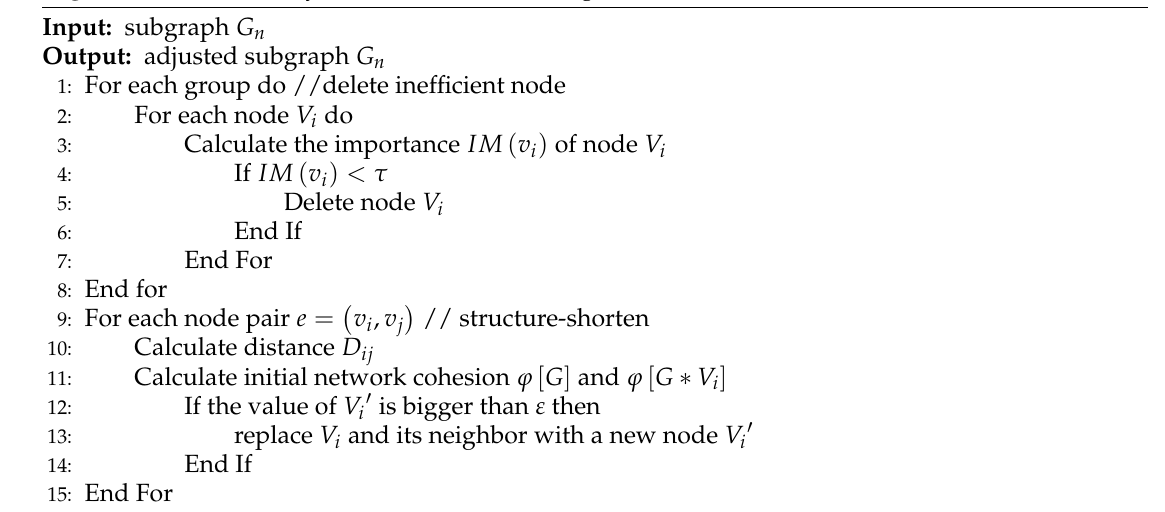
Algorithm 1 Community structure contraction